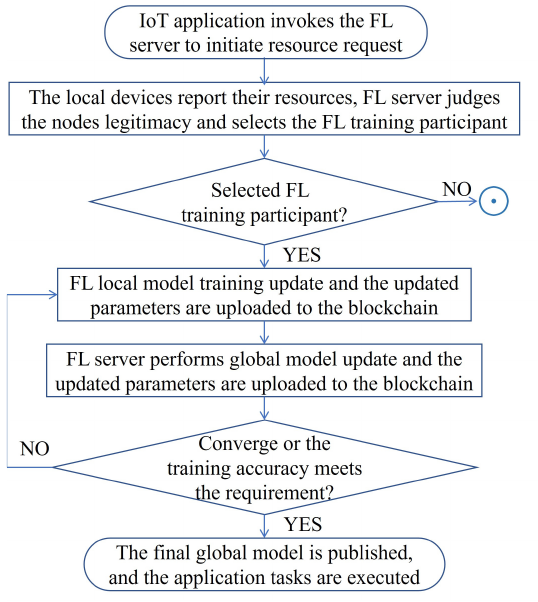
Figure 4. The flowchart of the proposed